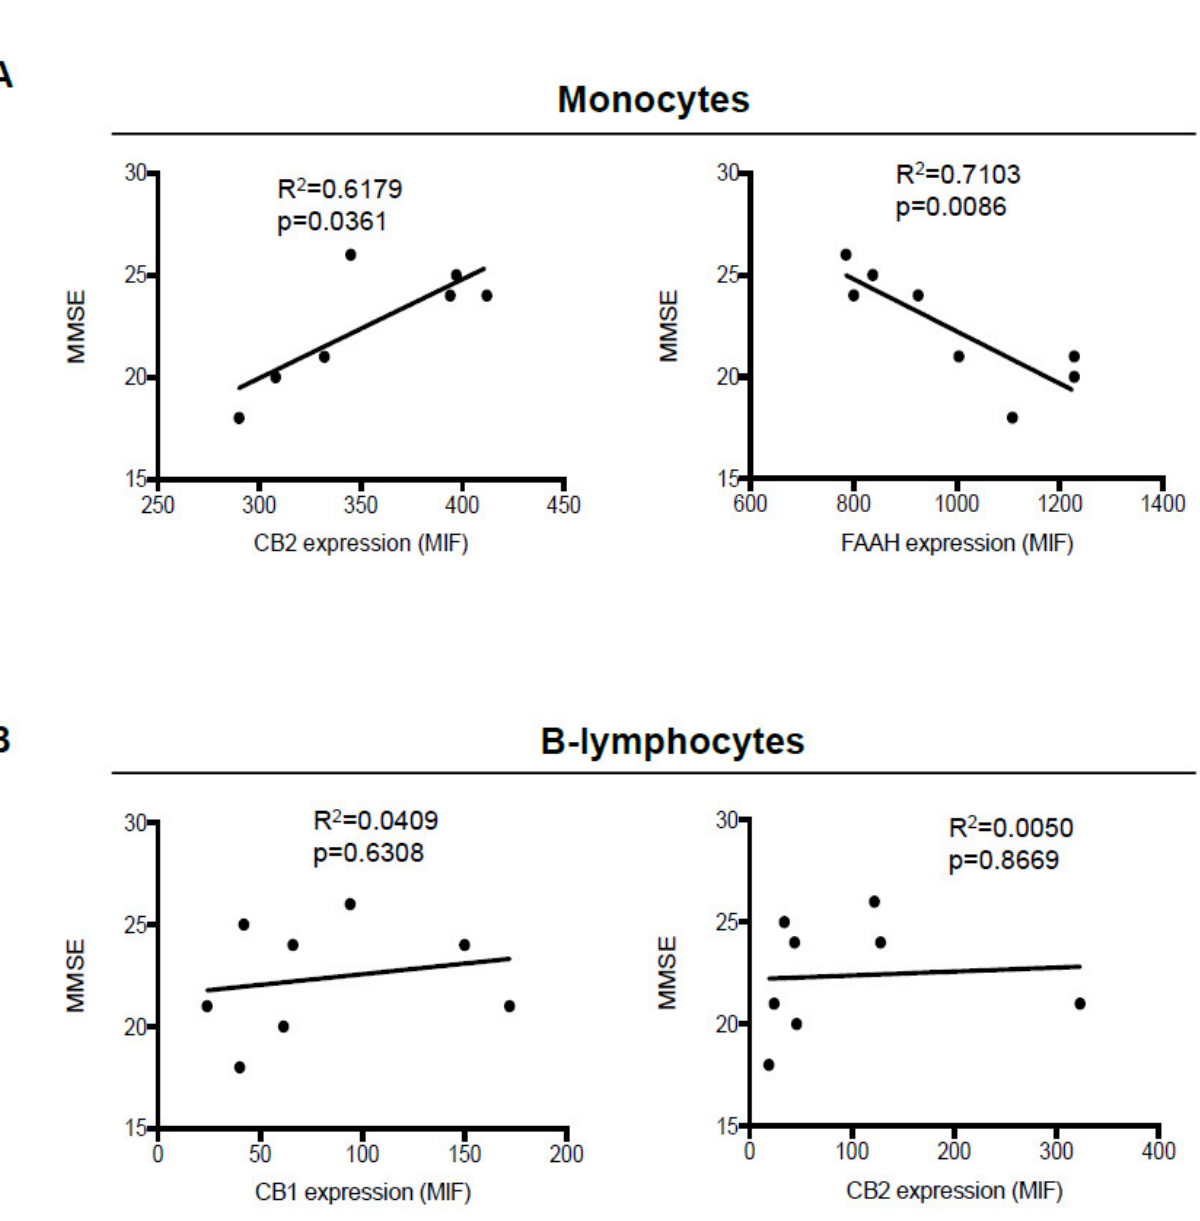
Figure 3. Correlation between mini-mental state examination (MMSE) scores and expression of eCB system members in monocytes and B-lymphocytes. Correlation plots between MMSE scores and expression (mean intensity fluorescence (MIF) values) of FAAH and CB 2 receptors in monocytes, ( A ) and of CB 1 and CB 2 receptors in B-lymphocytes ( B ) from AD patients. Data were compared by linear regression analysis ( p < 0.05).